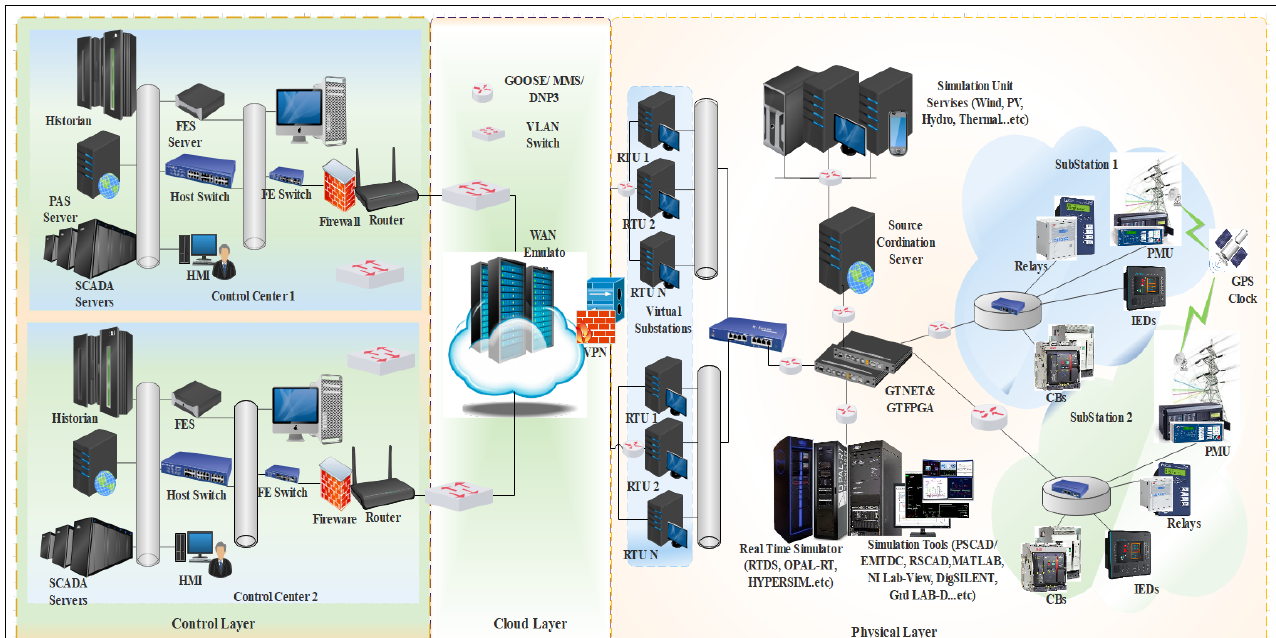
Figure 3. Generic Physical Architecture of CP-SG